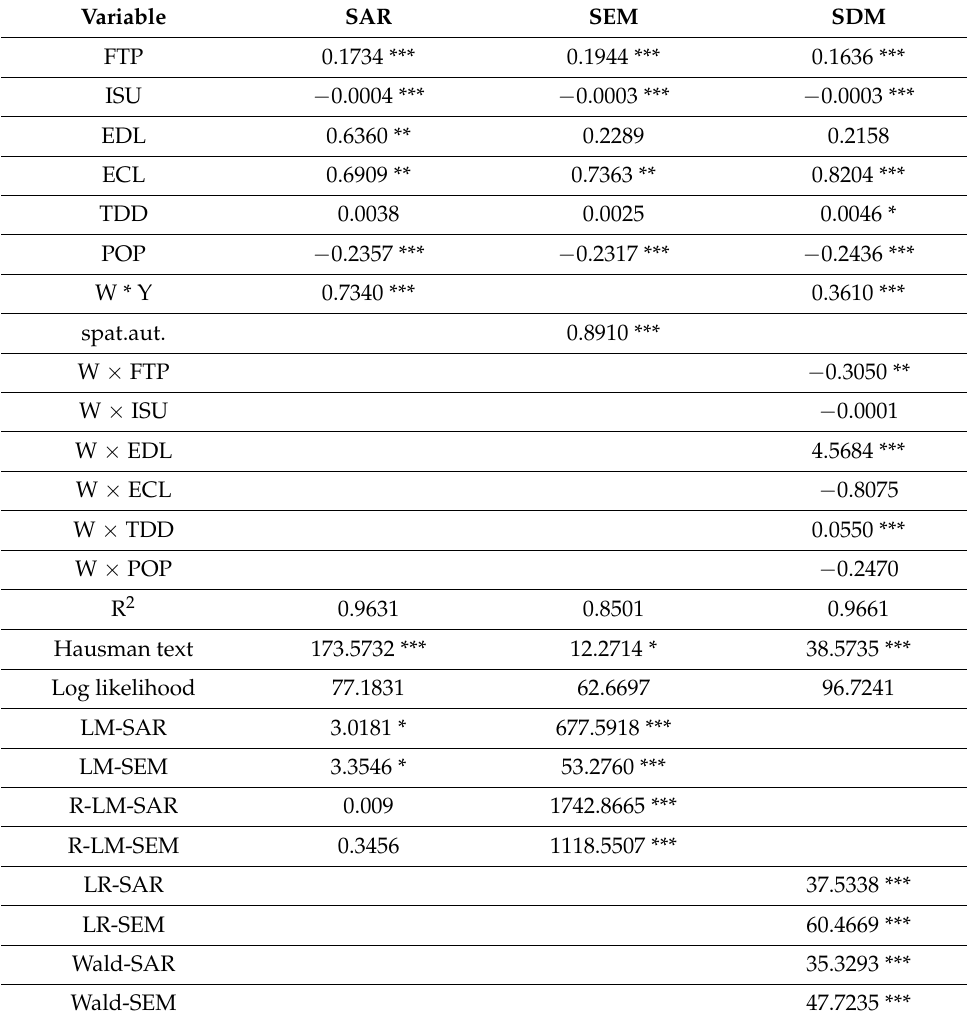
Table 6. Spatial panel regression model